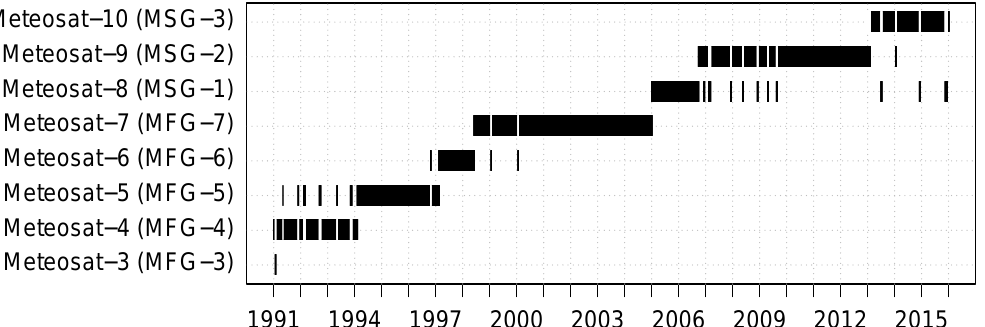
Figure 1. Meteosat satellites used in this study. MSG, Meteosat Second Generation; MFG, Meteosat First